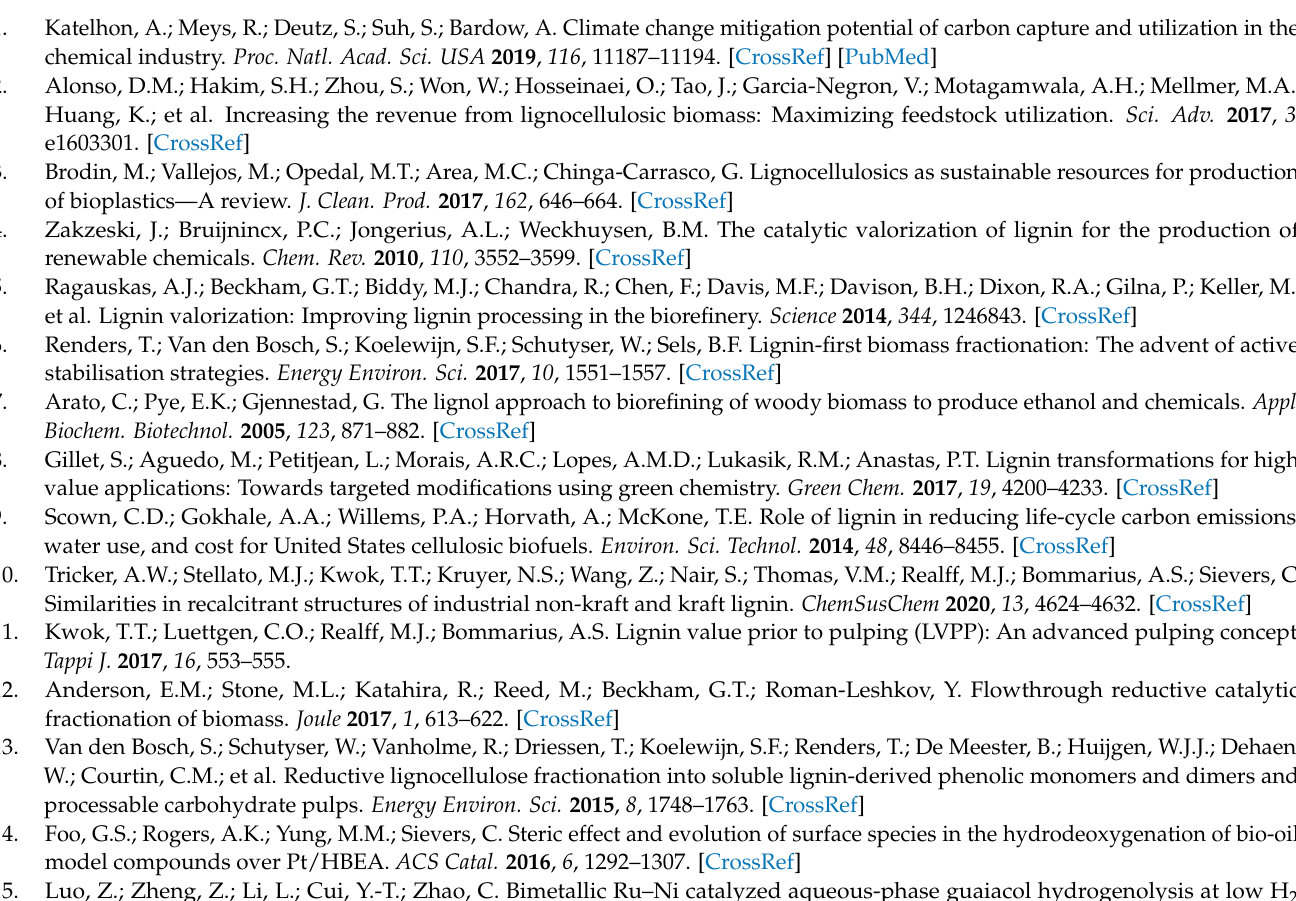
Figure S7: FTIR spectra of Phenol on ZSM-5, Figure S8: FTIR spectra of water regenerated phenol bands, Figure S9: FTIR spectra of aliphatic bands in deactivated ZSM-5, Figure S10: Deconvoluted 27 Al MAS NMR spectra of calcined